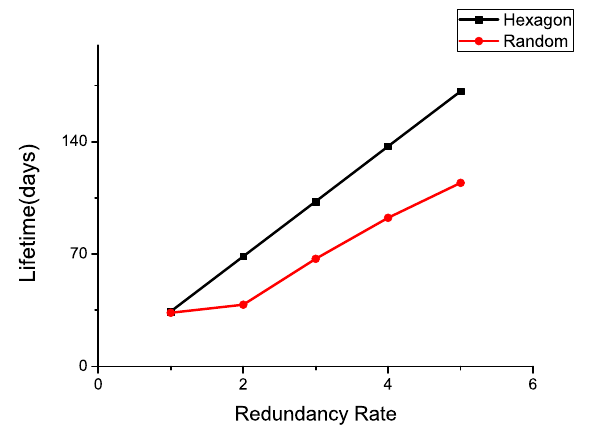
Figure 10. Lifetime under different redundancy